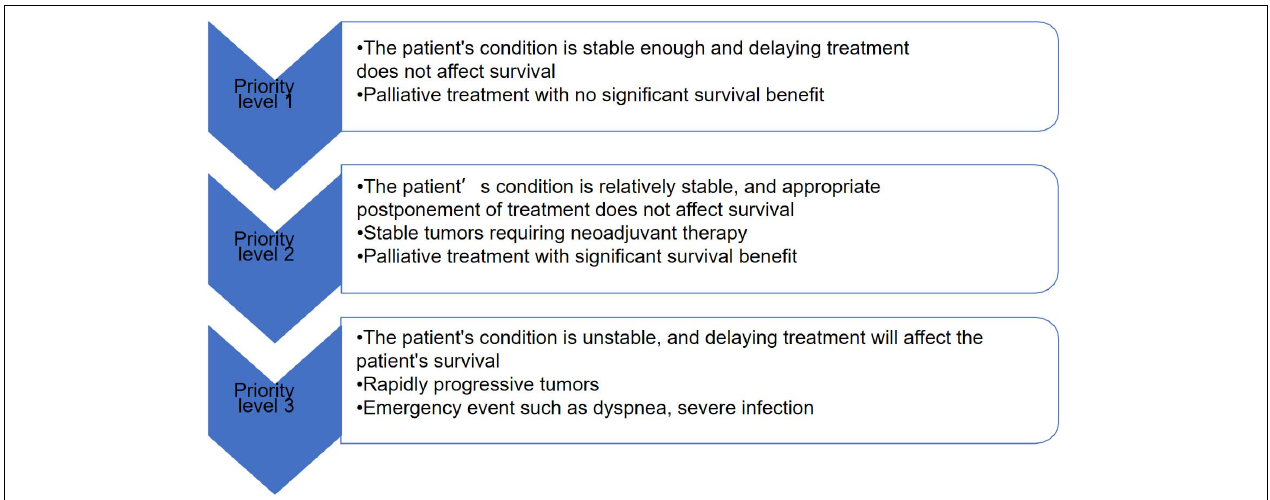
FIGURE 2 | Classified treatment management according to the actual situation of cancer